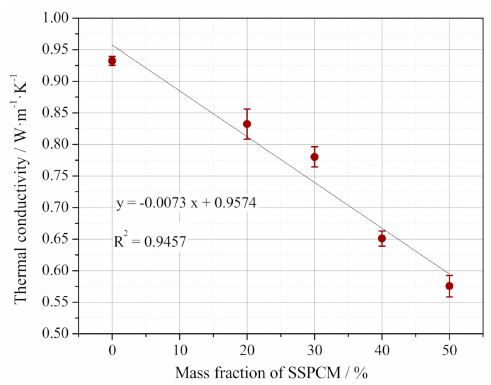
Figure 11. Thermal conductivity change of SCTESM with di ff erent dosages of